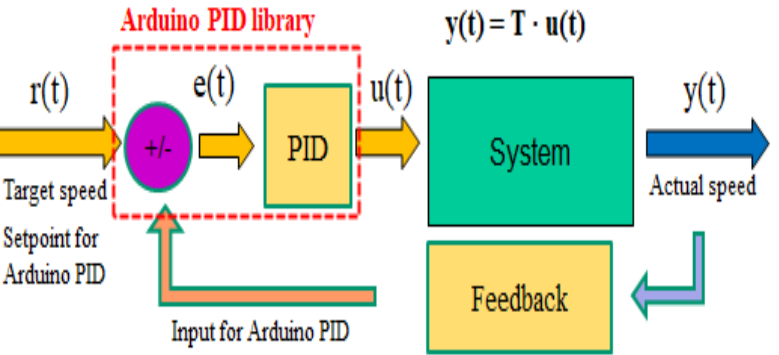
Figure 4. The hardware components used by the ventilation system.